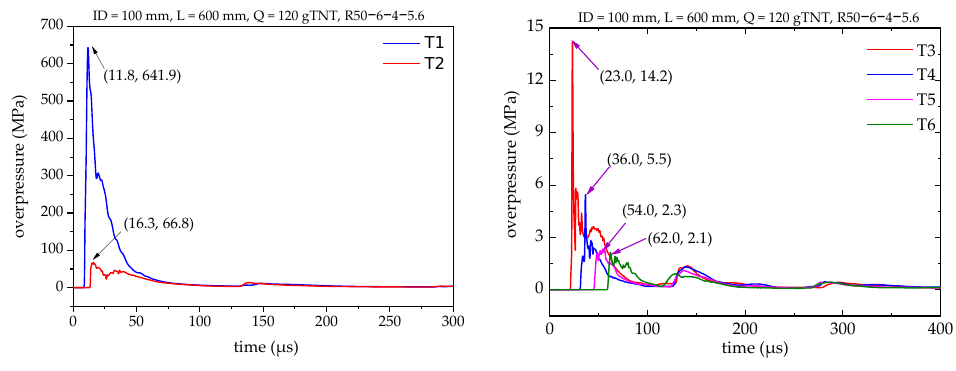
Figure 11. The pressure data observation points.